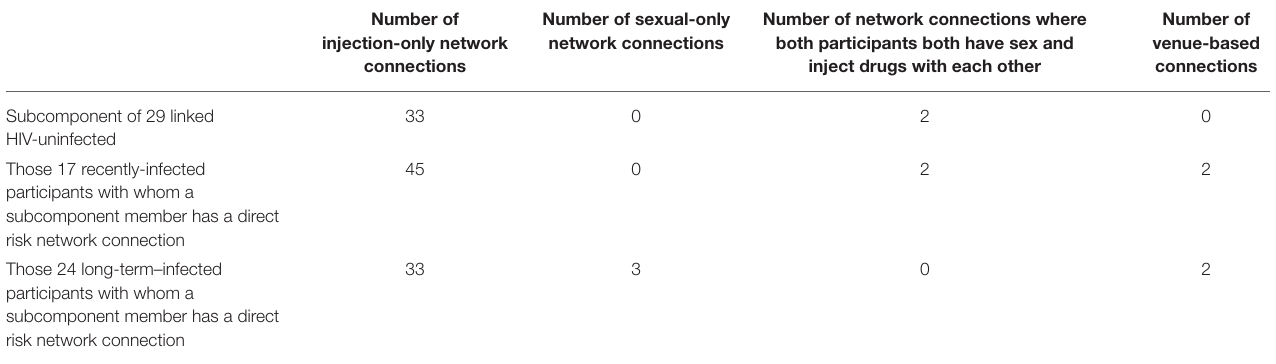
TABLE 1 | Numbers and kinds of links of members of the 29 member subcomponent of uninfected participants with each other and with the 17 recently infected participants and long-term infected participants. Number of injection-only